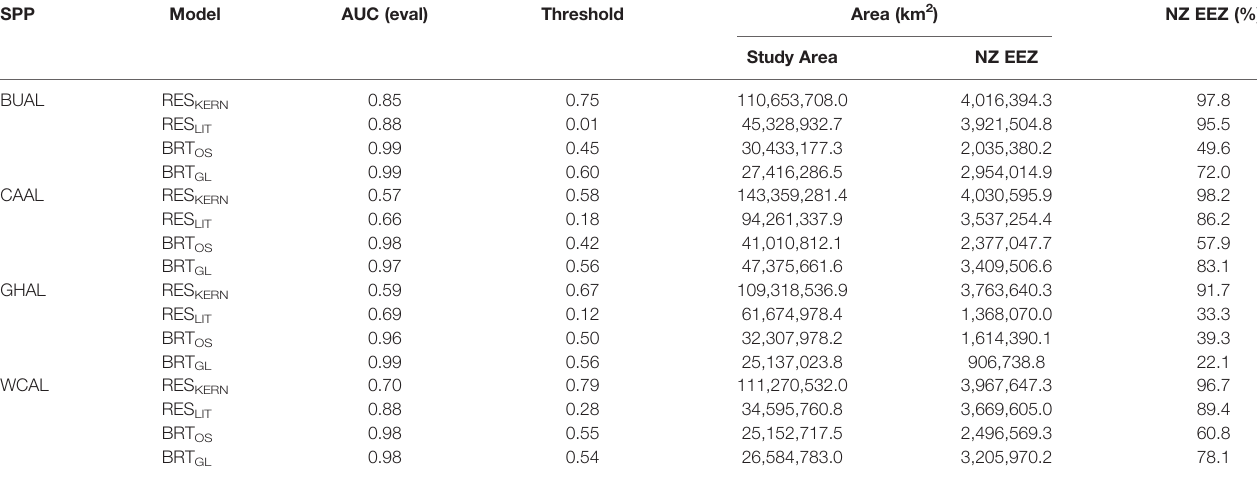
TABLE 2 | The area under the receiver operator characteristic curve (AUC) produced from evaluation data, optimal threshold values for delineating habitat, and area of habitat within the overall study area and the New Zealand Exclusive Economic Zone (EEZ) for four models: two Relative Environmental Suitability models (one fi t with values obtained from the monthly 50% kernel density contours from geolocation data (RES KERN ), and one fi t with values from the literature and expert opinion (RES LIT )) and two Boosted Regression Tree models (one fi t with opportunistic sightings data (BRT OS ), and one fi t with geolocation data (BRT GL )) for four species of albatrosses: Buller ’ s (BUAL), Campbell (CAAL), grey-headed (GHAL), and white-capped